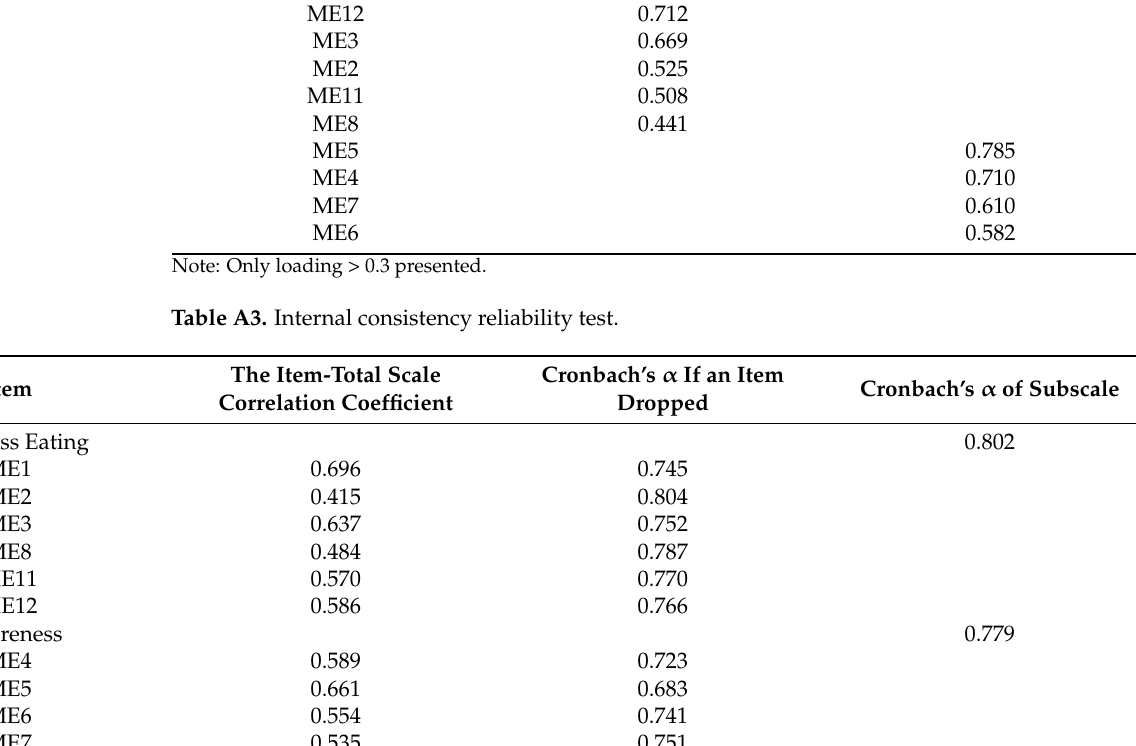
Table A4. Estimation of items parameters of the Mindless Eating subscale.